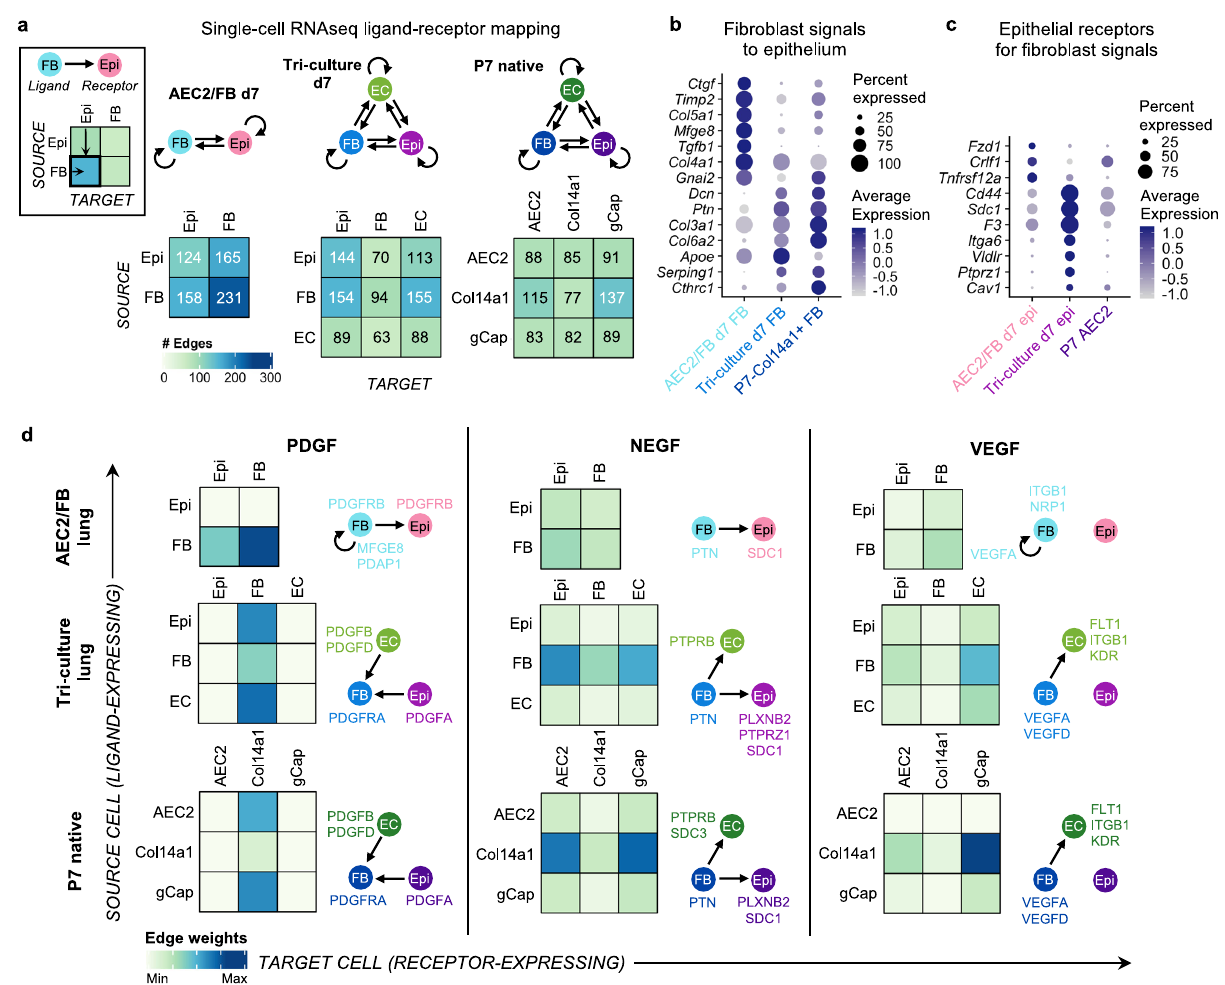
Fig. 5 Endothelial co-culture shifts fi broblast-AEC2 communication. a Schematic of signaling networks in d7 engineered lungs and amongst AEC2s, Col14a1 + FBs (Col14a1) and general capillary endothelial cells (gCap) in P7 native lung. Numbers indicate the total number of putative ligand-receptor (LR) pairs expressed along each cell – cell vector, as indicated in the heatmap key at left. b Dot plot of top differentially expressed FB ligands with epithelial cognate receptors in d7 engineered lungs. c Dot plot of top differentially expressed epithelial receptors with FB cognate ligands in d7 engineered lungs. d Heatmaps of summed edge weights for all LR pairs along the given cell – cell vectors within each of the indicated signaling pathways, in d7 engineered lungs and amongst native cell populations. Color scale for edge weights applies to each pathway individually. Schematics to the right of each panel indicate select top LR pairs contributing to the predominant signaling